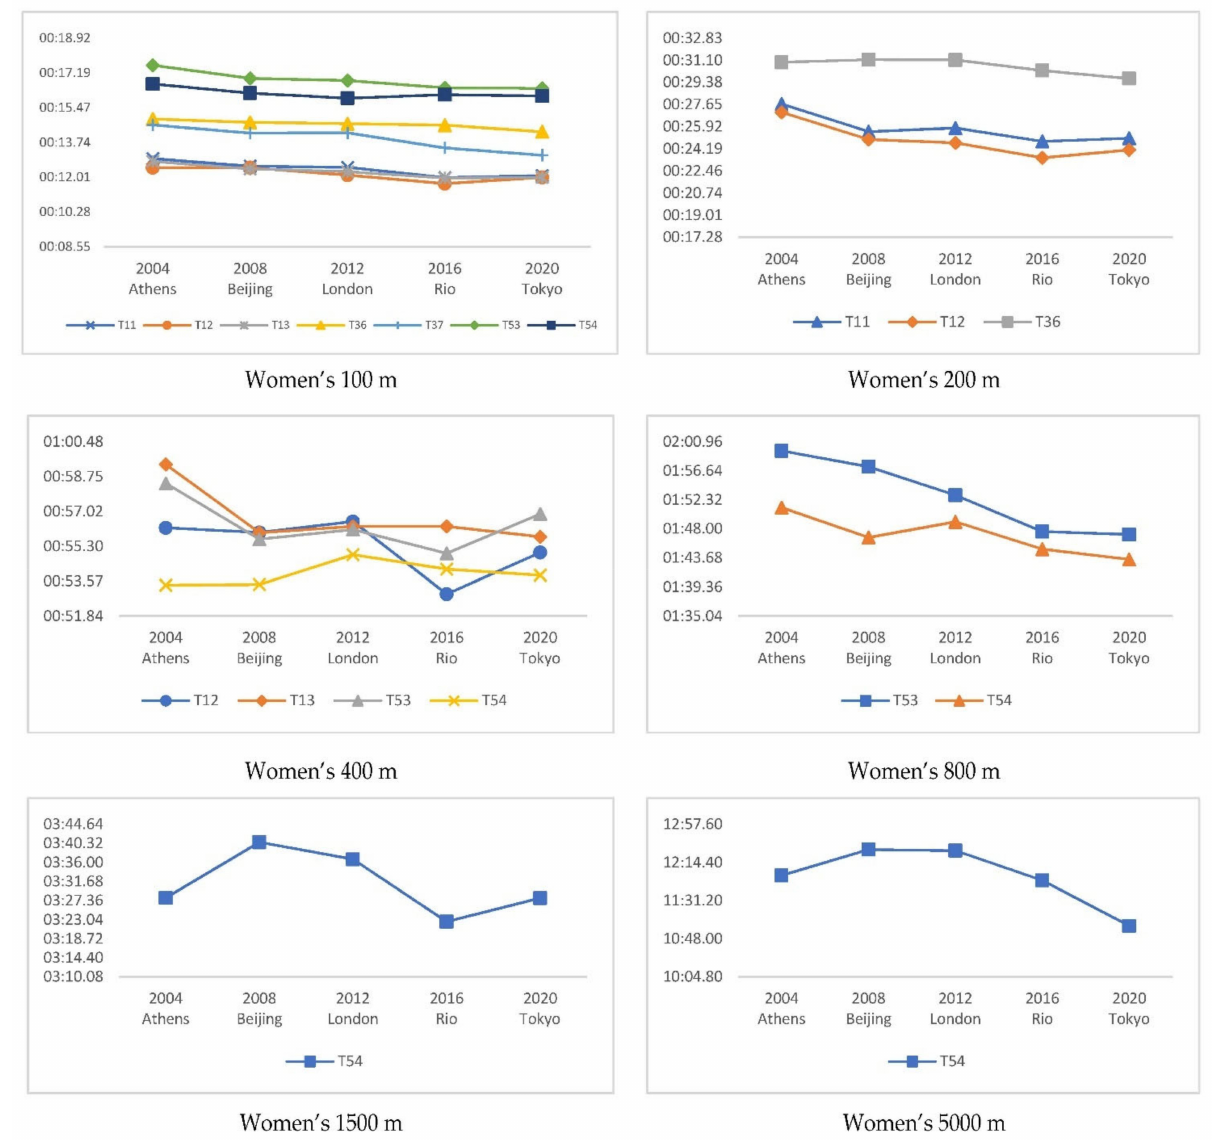
Figure 2. Women’s Division Record Change Trend in the Track Events of the Paralympic